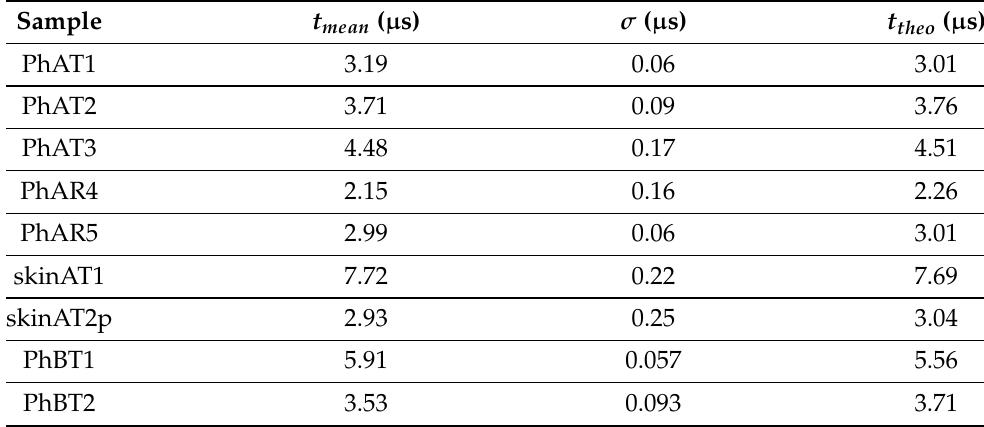
Table 1. The mean value t mean for all photoacoustic acquisition times of all samples considering, its standard deviation σ , and the theoretical acoustic transit time t theo are